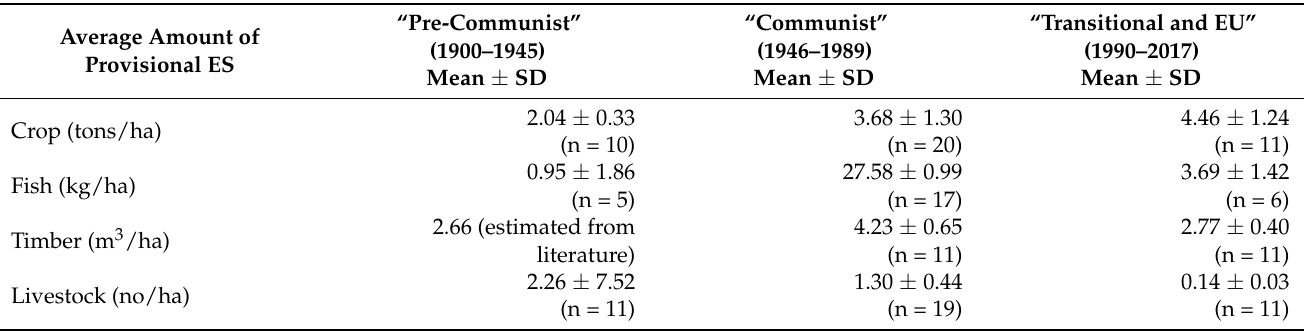
Table 2. Average values of the provisional ecological services for the Br ă ila Islands case study area during three periods of environmental history (n—number of samples, see Supplementary Table S1 for data source